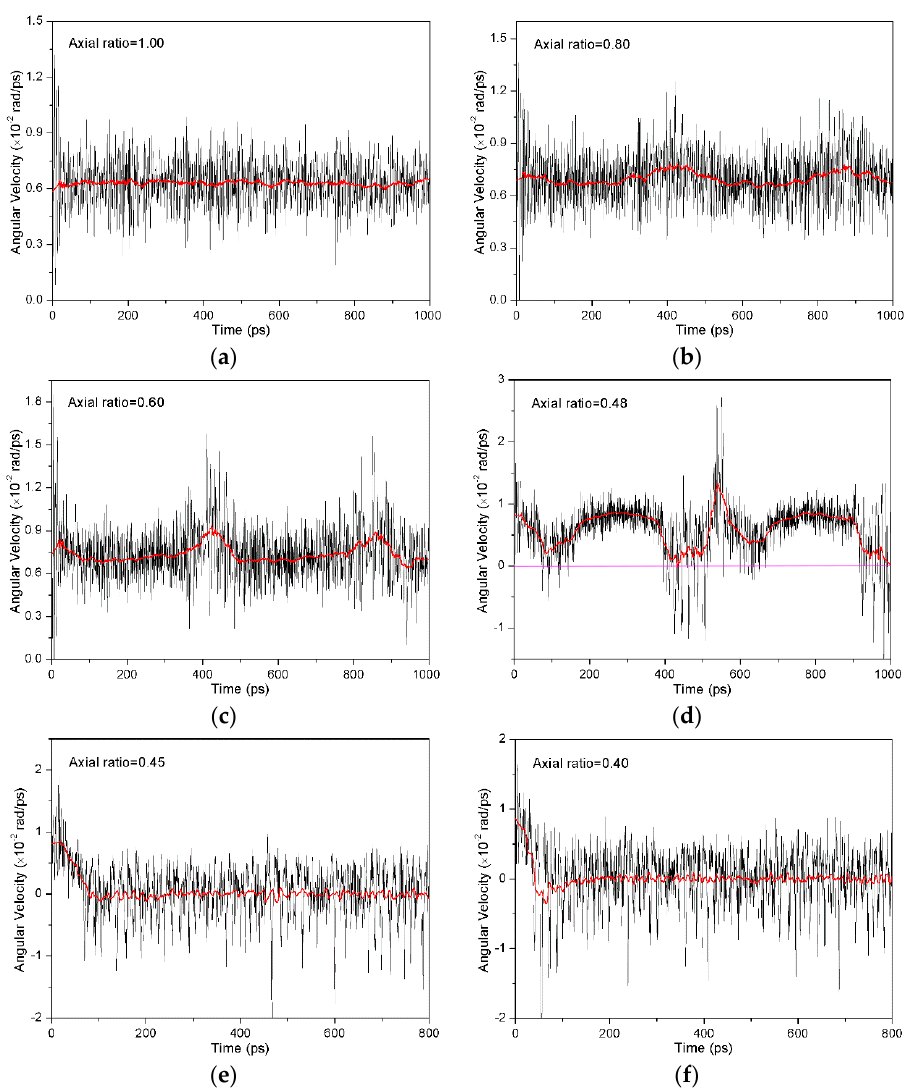
Figure 3. Angular velocity of abrasive center-of-mass vs. time at different abrasive axial ratio ( a ) 1.00, ( b ) 0.80, ( c ) 0.60, ( d ) 0.48, ( e ) 0.45, and ( f ) 0.40.